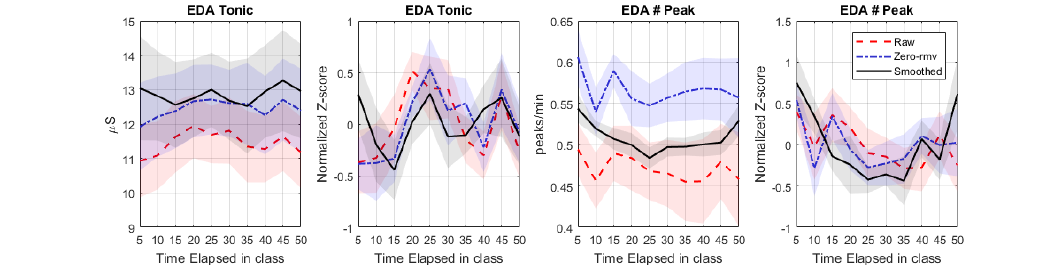
Figure 12. Comparison of (absolute and normalized) features calculated from raw EDA signals (Raw), signals after removing invalid portions (zero-rmv), and signals after applying the S-G filter (smoothed) for 11 participants whose signals were heavily contaminated by artifacts. A shade area represents √ N where N = 11 SD/